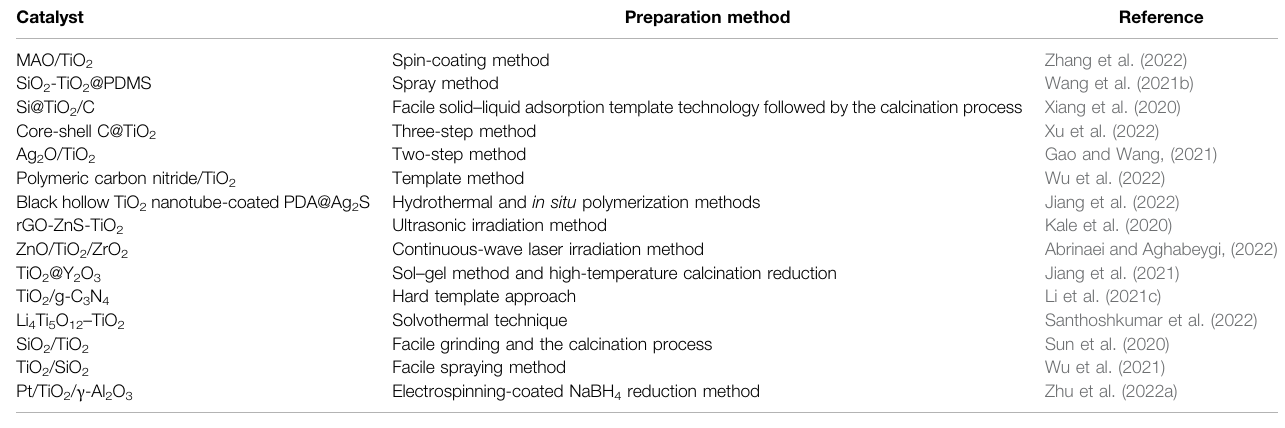
2 -based composite photocatalysts.